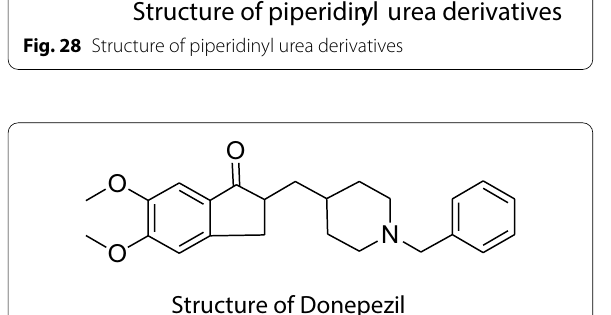
Fig. 29 Structure of